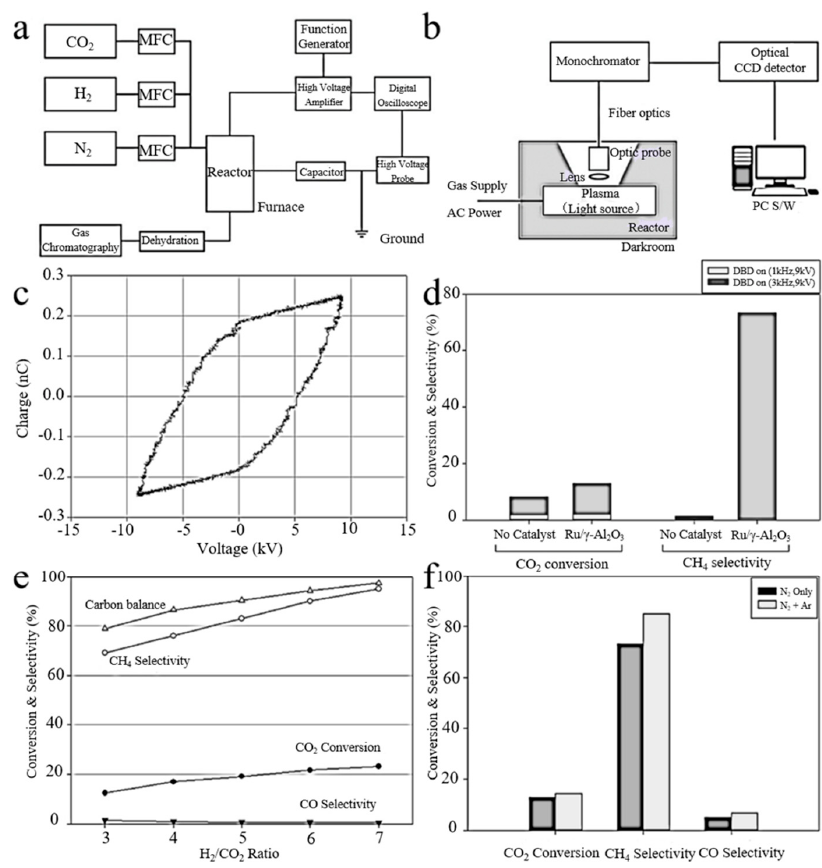
Figure 6. ( a ) the diagram of a methanation experimental device; ( b ) the diagram of experimental device for optical emission spectroscopy; ( c ) Lissajous diagram of the DBD plasma; ( d ) comparison of the CH 4 selectivity and CO 2 conversion; ( e ) e ff ect of the H 2 / CO 2 ratio on the CH 4 selectivity and CO 2 conversion for Ru / γ -Al 2 O 3 ; ( f ) e ff ect of Ar on DBD over Ru / γ -Al 2 O 3 . Reproduced with permission from [84]; Copyright Elsevier, 2017.